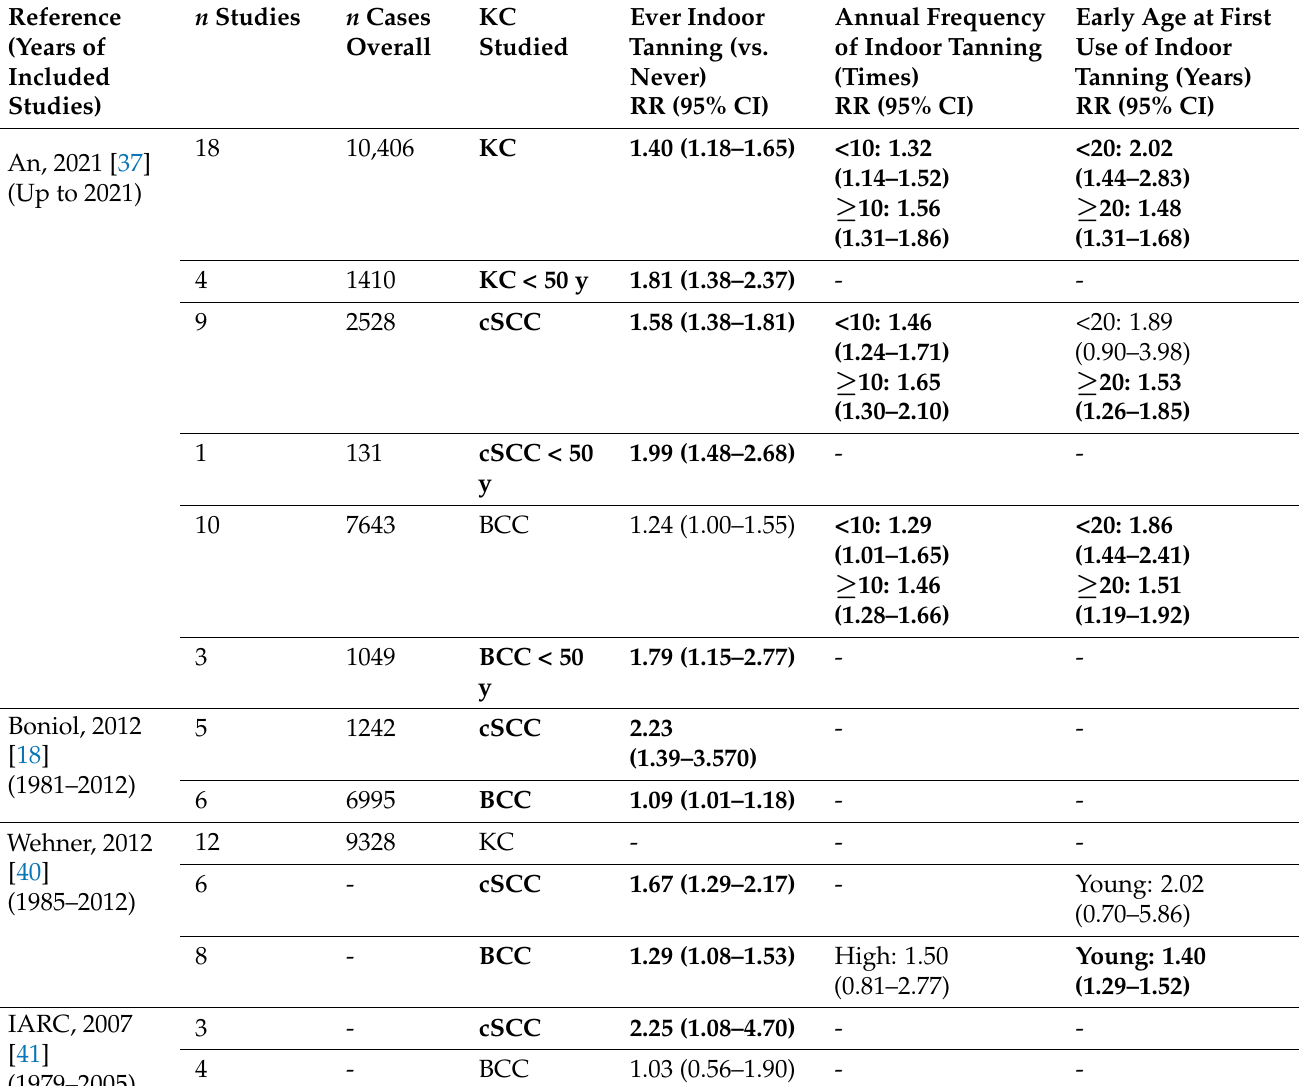
Table 3. Meta-analyses reporting indoor UVR tanning and risk of keratinocyte carcinoma. Available results by age group and dose/frequency of sunbed use are